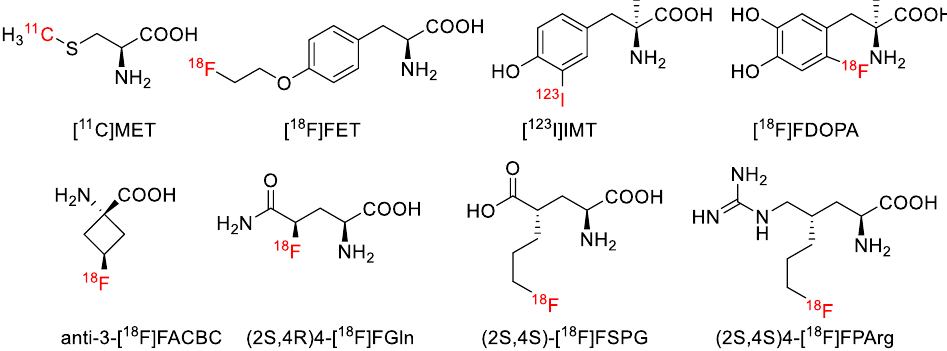
Figure 1. Chemical structures of [ 11 C]MET, [ 18 F]FET, [ 123 I]IMT, [ 18 F]FDOPA, anti – 3 – [ 18 F]FACBC, (2S,4R)4 – [ 18 F]FGln, (2S,4S) – [ 18 F]FSPG and (2S,4S)4 – [ 18 F]FPArg. (2S,4R)4–[ 18 F]FGln, (2S,4S)–[ 18 F]FSPG and (2S,4S)4–[ 18